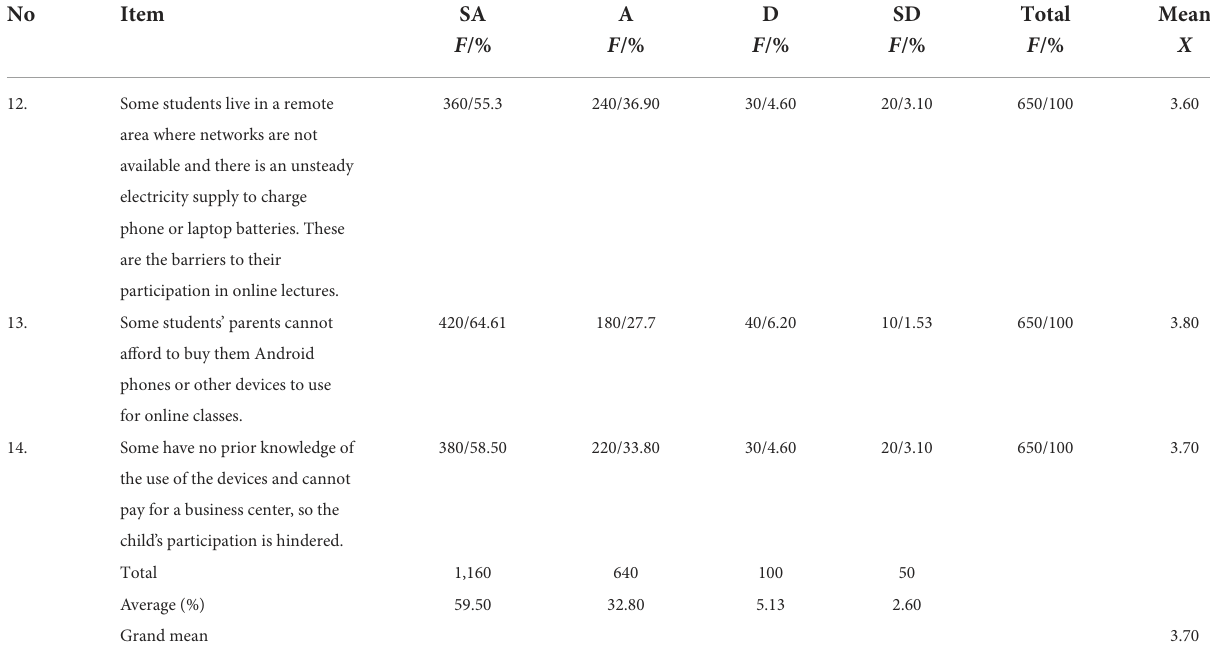
TABLE 3 Responses on the structural barriers that hampered the students’ successful participation in the online